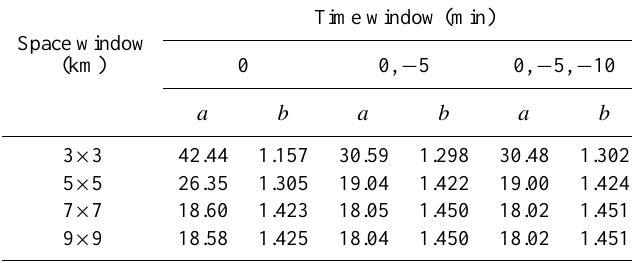
Table 4. Parameters a and b in Z e − R relationship (Eq. 4) for different WCMM scenarios.